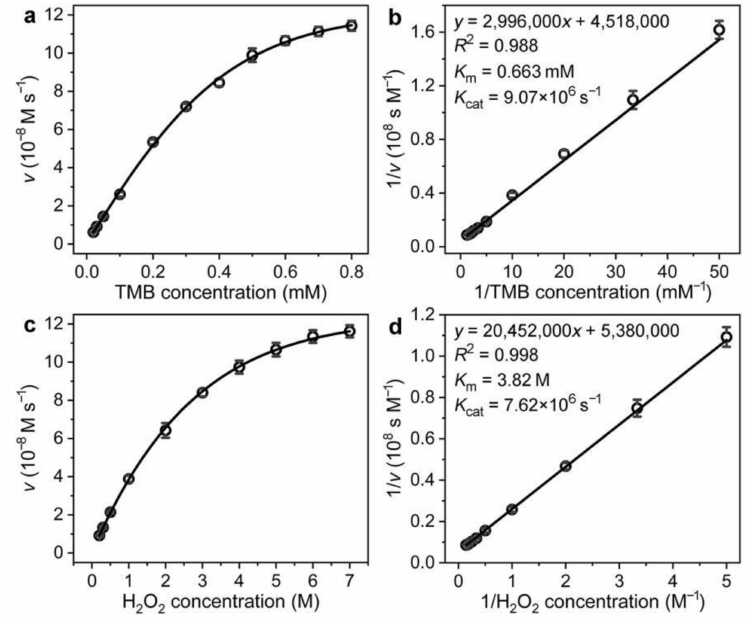
Figure 3. Steady-state kinetic analysis of the peroxidase-like catalytic activity of Pd@Pt NDs. ( a , b ) Ki- netic analysis toward TMB: ( a ) plot of v versus TMB concentration, in which 7.0 M H 2 O 2 was used; ( b ) double-reciprocal plot converted from ( a ). ( c , d ) Kinetic analysis toward H 2 O 2 : ( c ) plot of v versus H 2 O 2 concentration, in which 0.8 mM TMB was used; ( d ) double-reciprocal plot converted from ( c